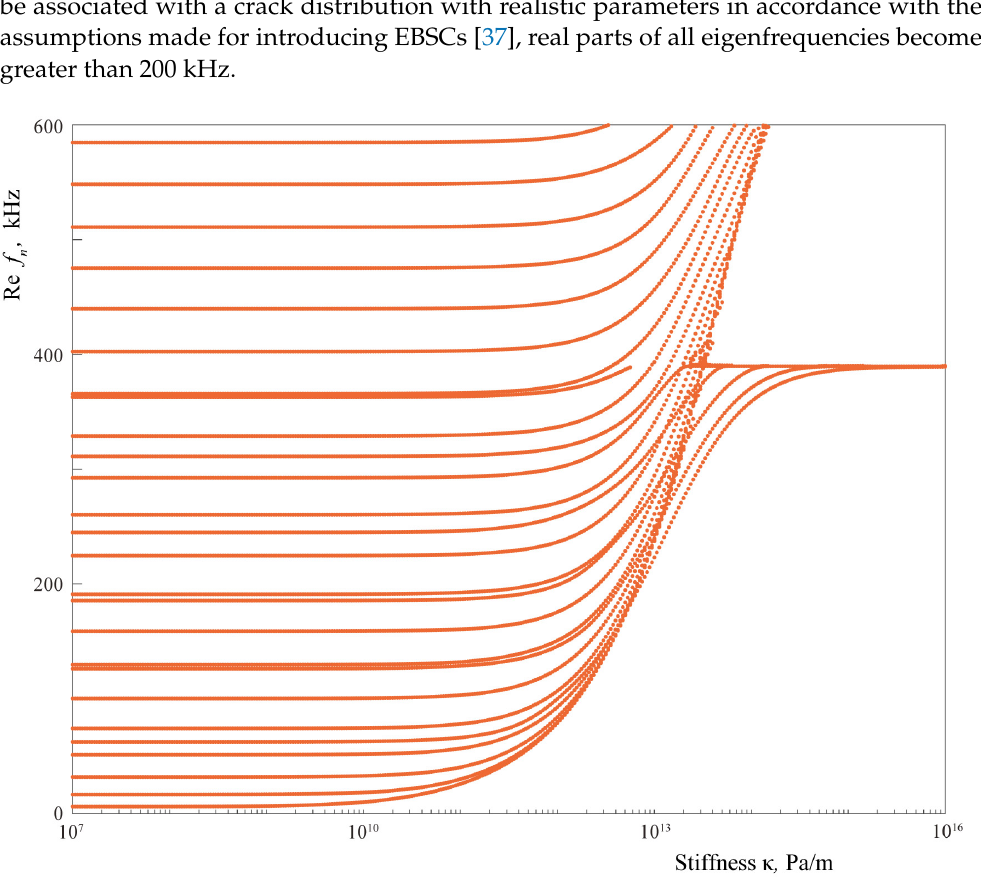
Figure 16. Eigenfrequencies f n ( κ ) with imaginary part | Im f n | ≤ 2 kHz of the laminate with an interfacial uniform partially closed delamination of length w = 40 mm modelled using